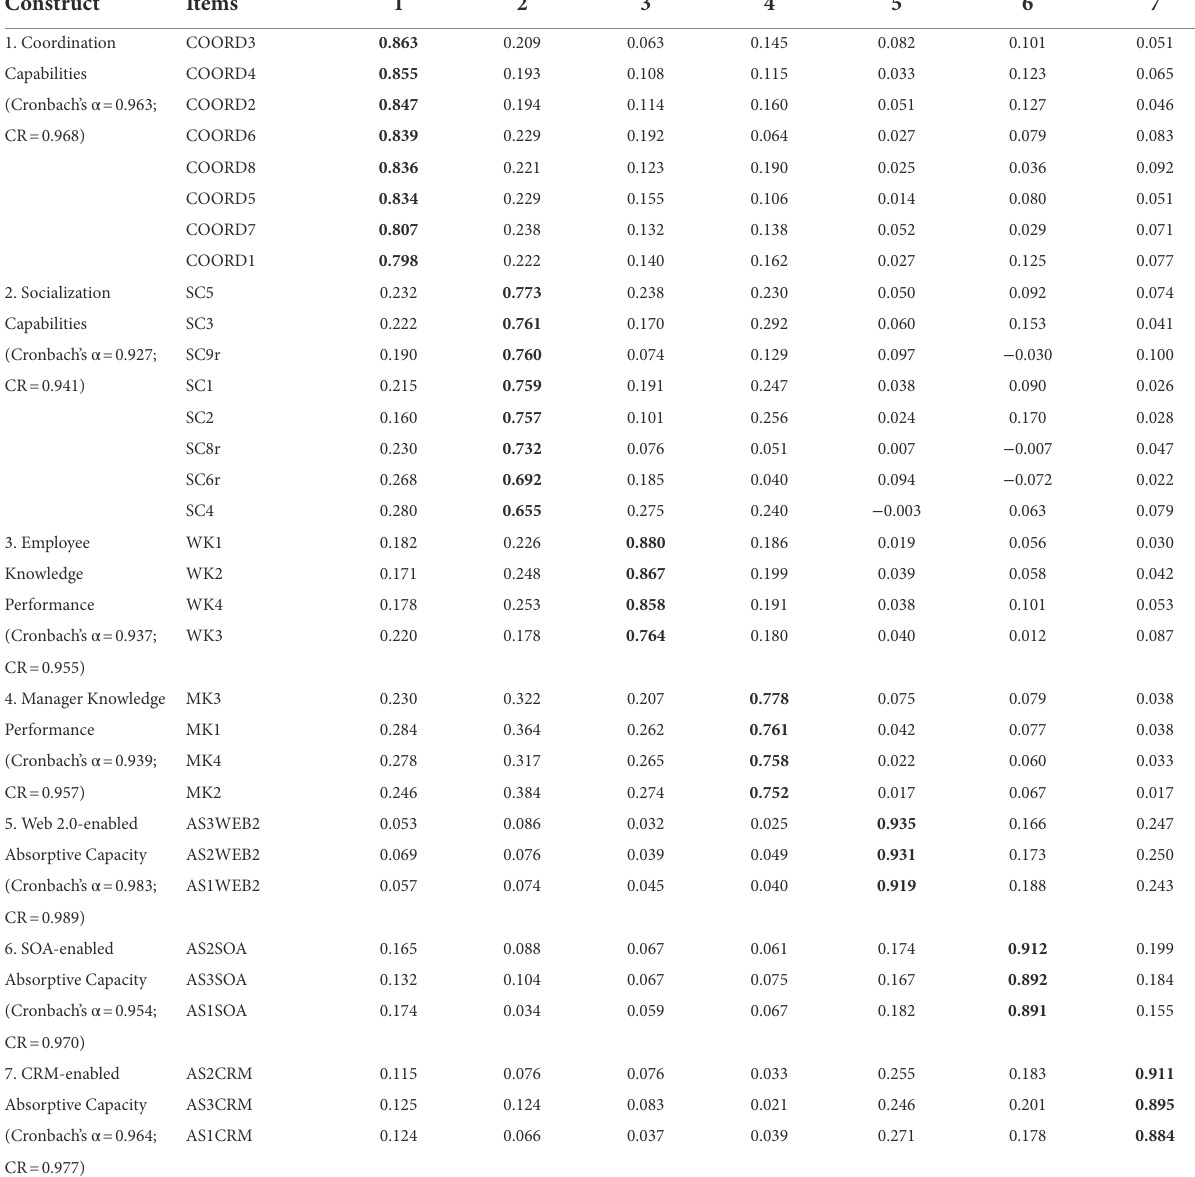
TABLE 2 Cronbach’s α , composite reliability, and item loadings and